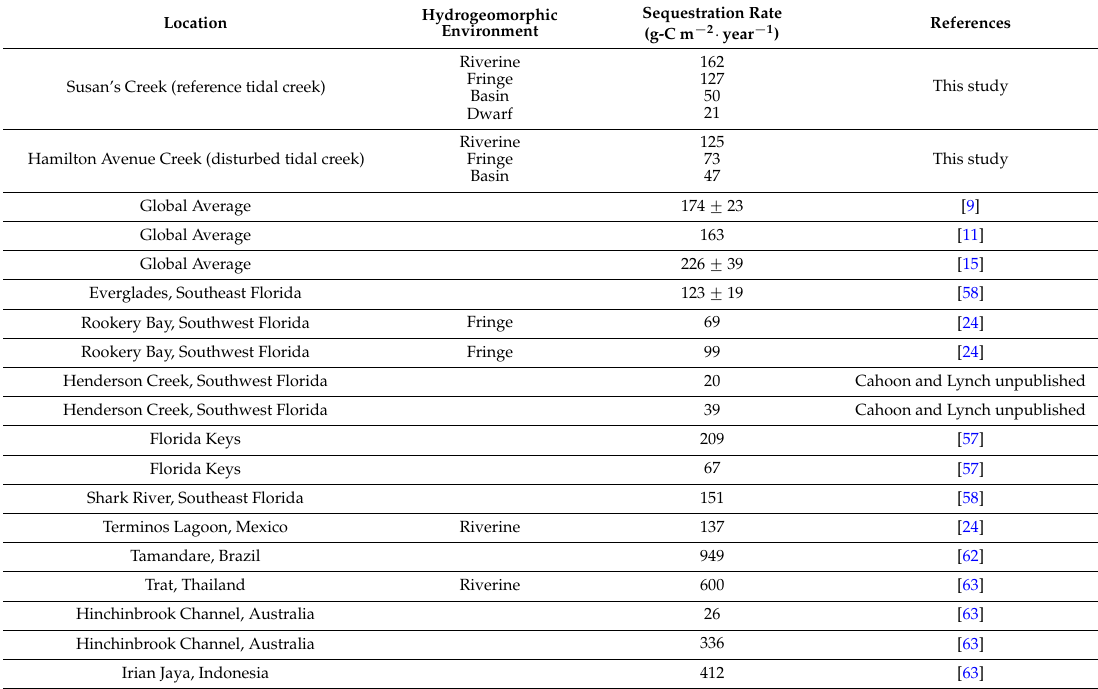
Table 3. Comparison of mangrove carbon sequestration rates in this study with other published local, regional, and global rates of carbon sequestration in mangrove